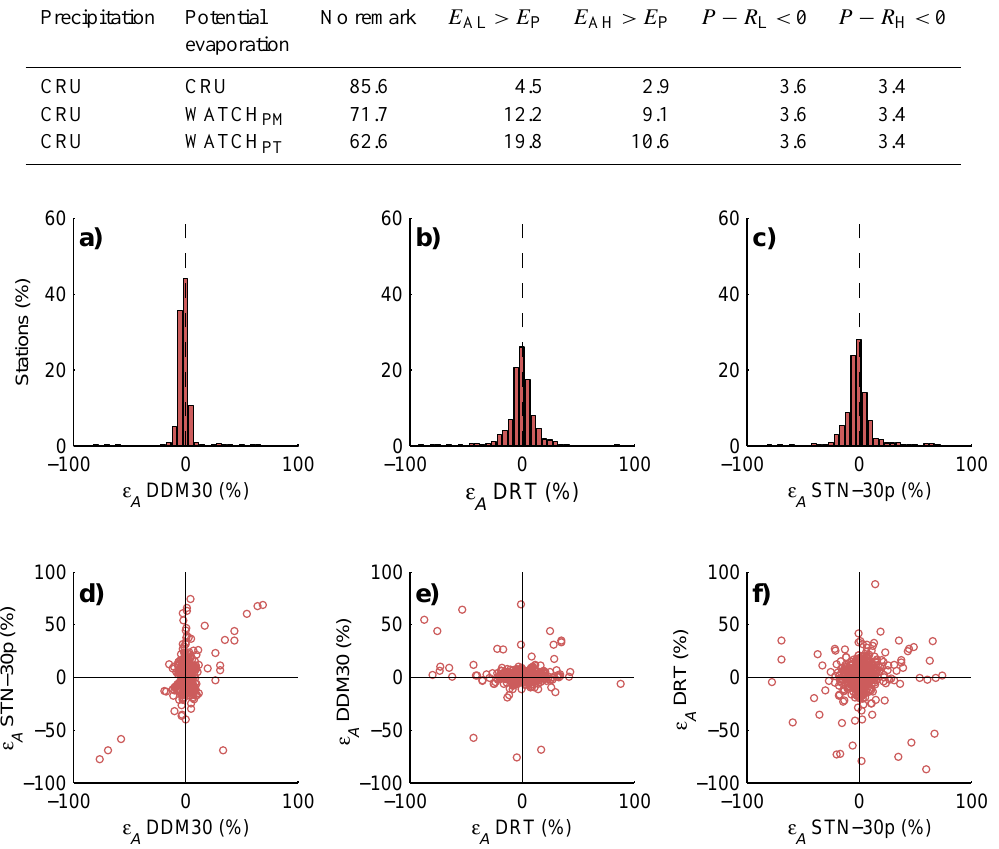
Fig. 4. Histograms of relative area differences for 558 basins with stations registered in the three gridded flow networks: (a) DDM30, (b) DRT and (c) STN-30p. The lower panel shows comparisons of the relative area differences for each basin in the different flow networks.